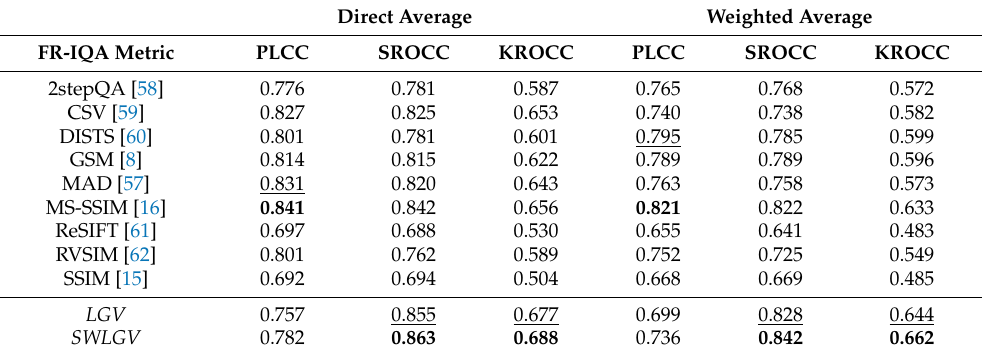
Table 4. Comparison of LGV and SWLGV to the state-of-the-art. Direct and weighted average PLCC, SROCC, and KROCC values are reported. Measured on KADID-10k [5], TID2013 [3], TID2008 [56], and CSIQ [57]. The highest values are typed in bold , while the second highest ones are underlined. Direct Average Weighted Average